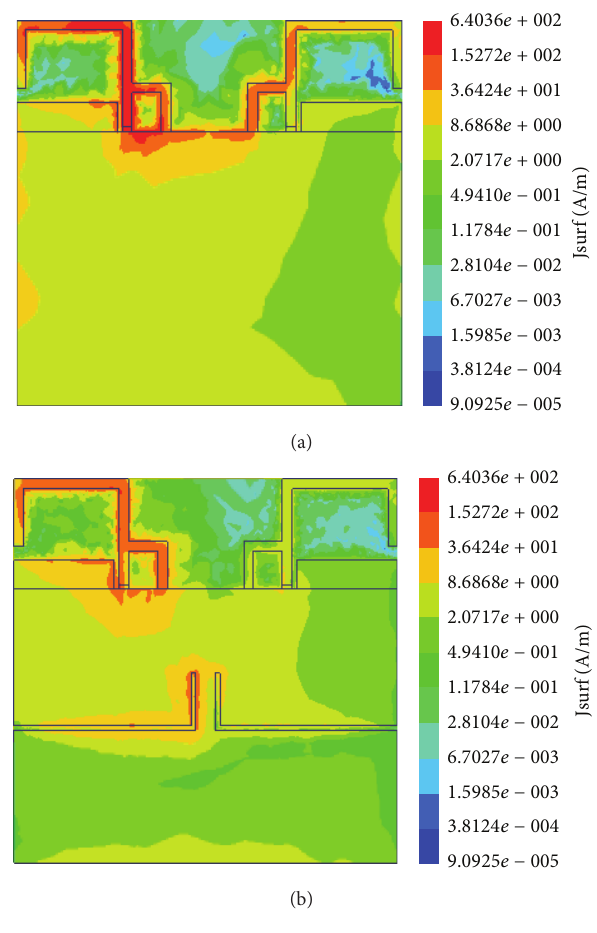
Figure 5: Simulated surface current distributions for the proposed antenna at 2.44 GHz (port 1: on, port 2: off) (a) without slit and (b) with slit.